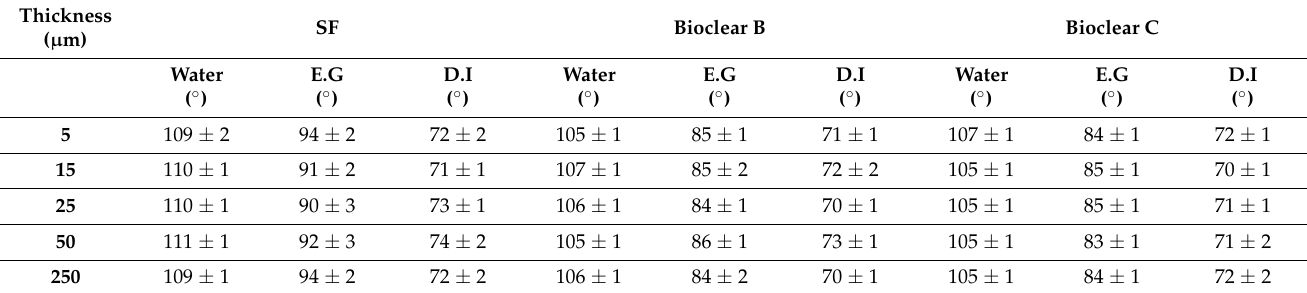
Table A2. CA values of water, ethylene glycol, and diiodomethane on soft PDMS surfaces with different thicknesses. The CA values did not show significant differences with varying thickness.